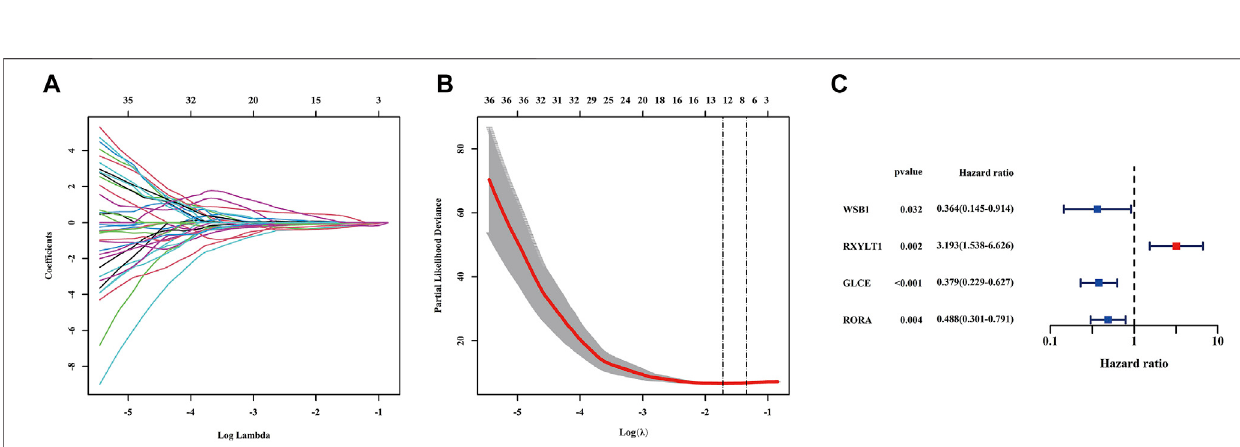
FIGURE 2 | Identi fi cation of protective or risk HRGs by LASSO and multivariate Cox regression analysis in the training cohort. (A) LASSO regression of the 52 HRGs. (B) Cross-validation for tuning parameter selection in the LASSO regression. (C) Candidate HRGs to construct gene signature by multivariate Cox regression analysis. LASSO = least absolute shrinkage and selection